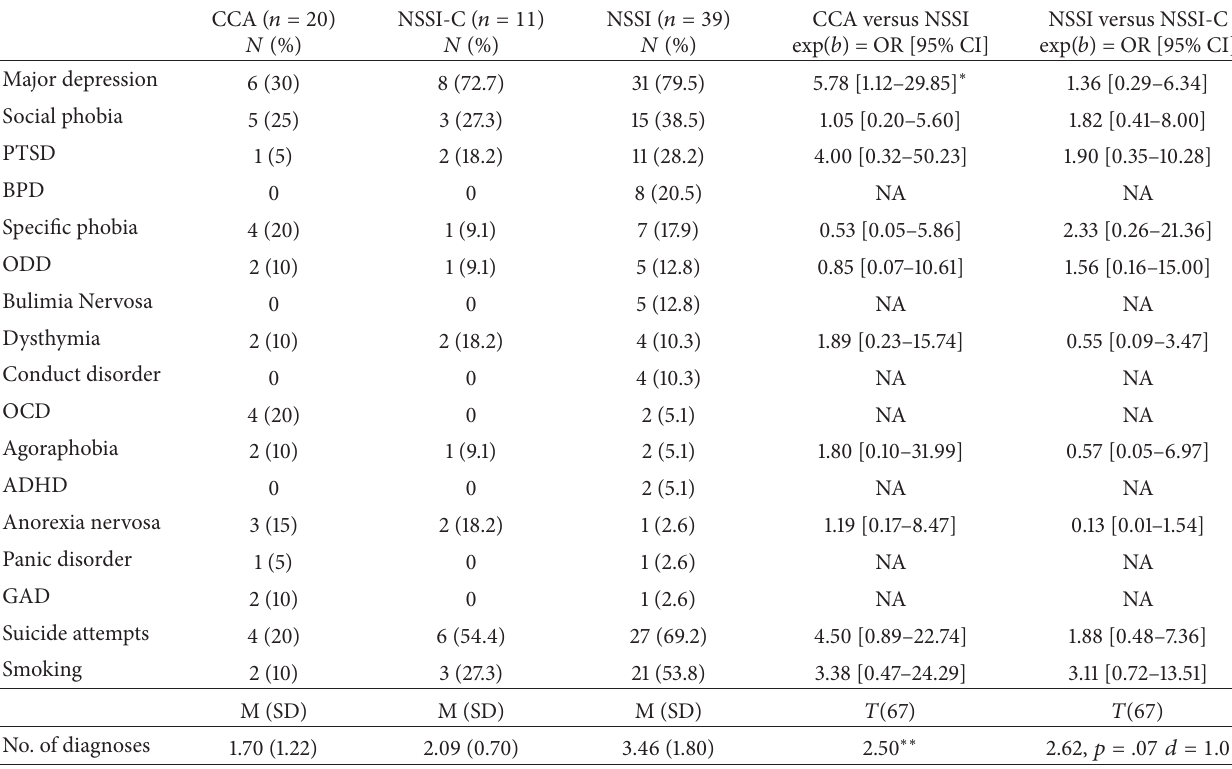
Table5:DiagnosticcorrelatesofadolescentswithclinicaldiagnoseswithoutNSSI(CCA),adolescentswithNSSIwithoutimpairment/distress (NSSI-C), and adolescents with NSSI (NSSI), as well as logistic regressions and orthogonal comparisons between clinical controls and NSSI (CCA versus NSSI) and between NSSI disorder and NSSI-C (NSSI versus